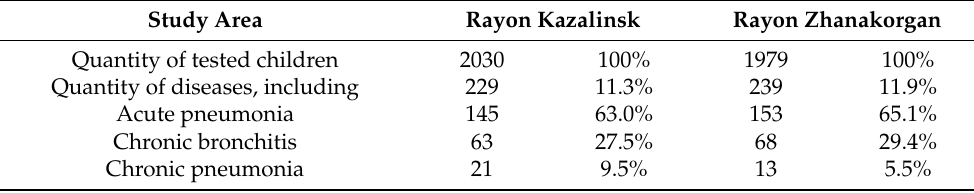
Table 1. Diseases of respiratory tracts in children in two Kazakh Rayons of the Aral Sea basin 1989. Study Area Rayon Kazalinsk Rayon Zhanakorgan